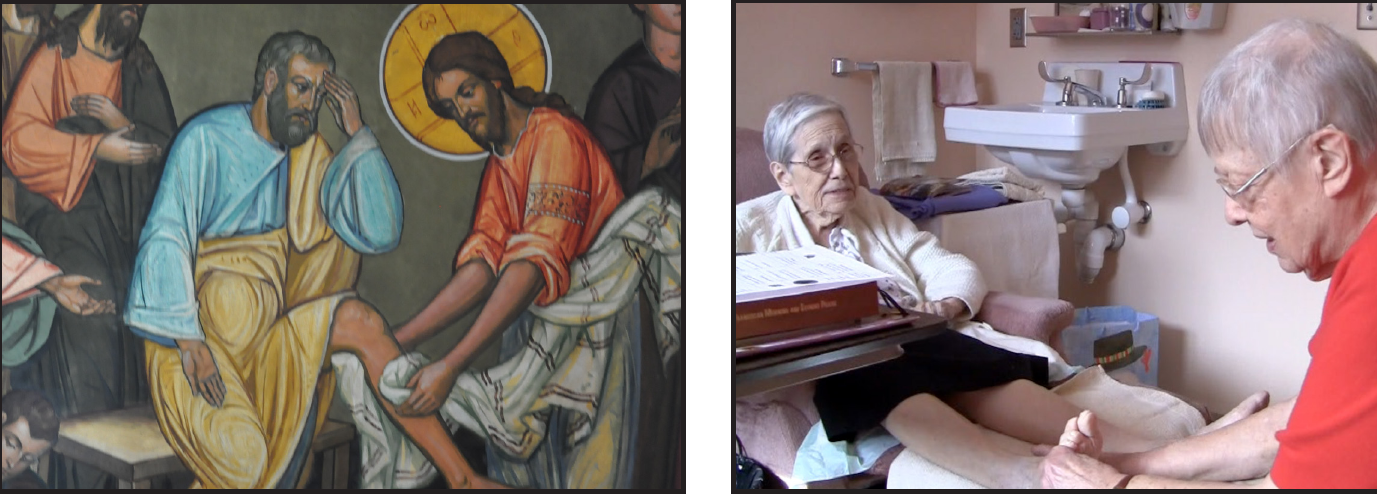
Figure 3: Images of Jesus with the disciples Figure 4: Image of Sr. Irma massaging her peer’s